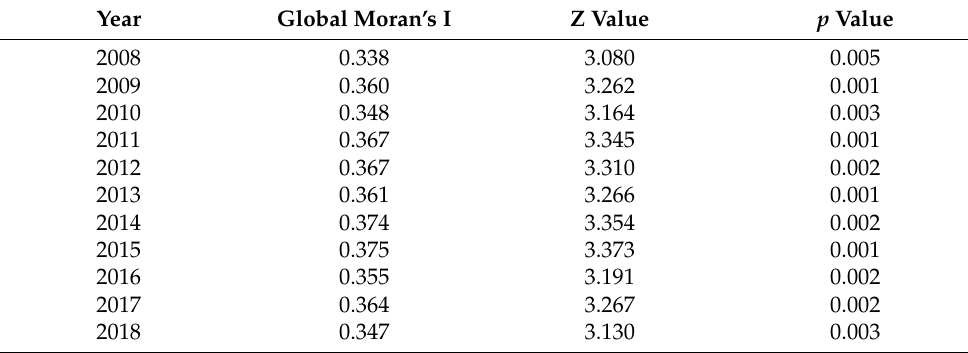
Table 3. Global Moran (cid:48) s I index of corn production cost of China from 2008 to